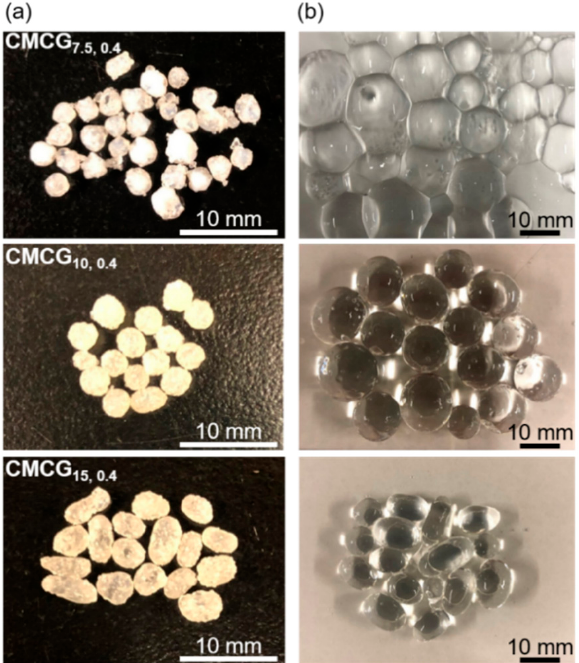
Figure 3. Photographs showing the appearance of the CMCGs: ( a ) dried and ( b ) swollen with PBS.